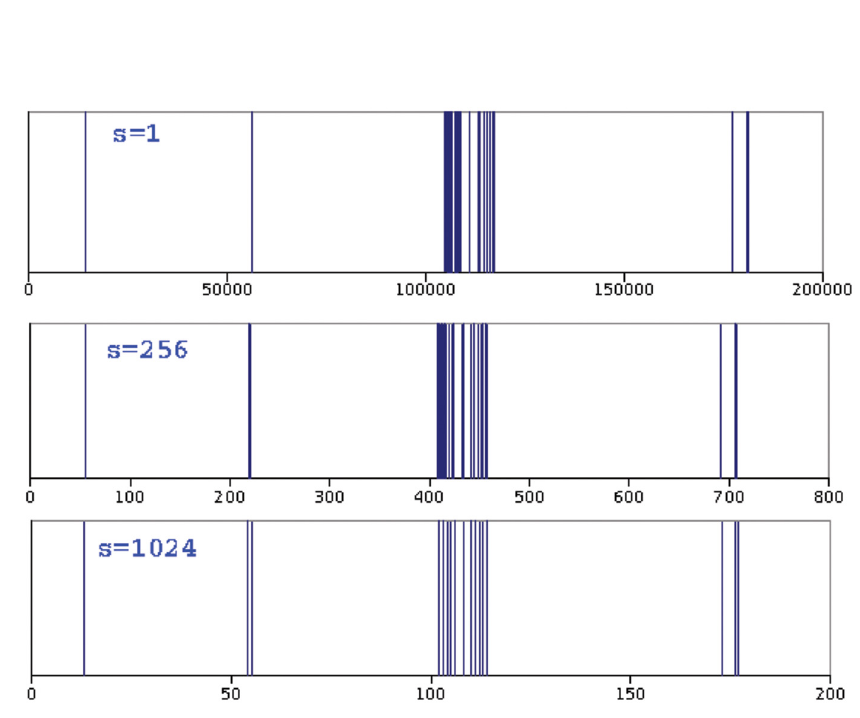
Fig 3. Schematic of how an instance text is devided into boxes. The number of words that is placed in a box, is the box-size. Box-Size for first row is equal to 2 and for the second and third rows are 4 and 8 respectively.